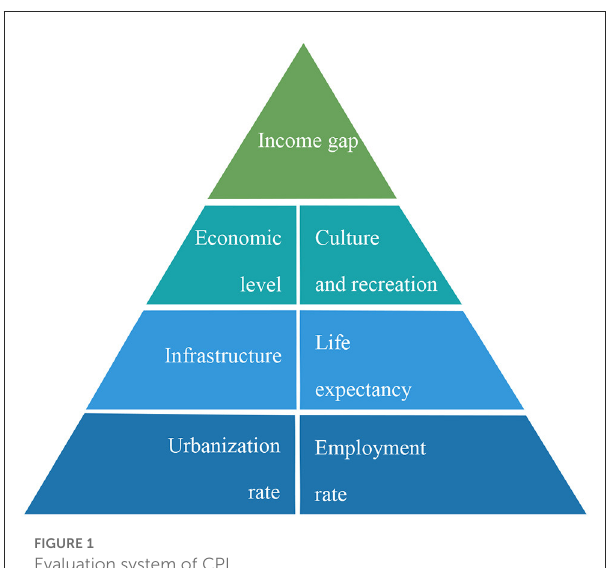
FIGURE1 Evaluation system of